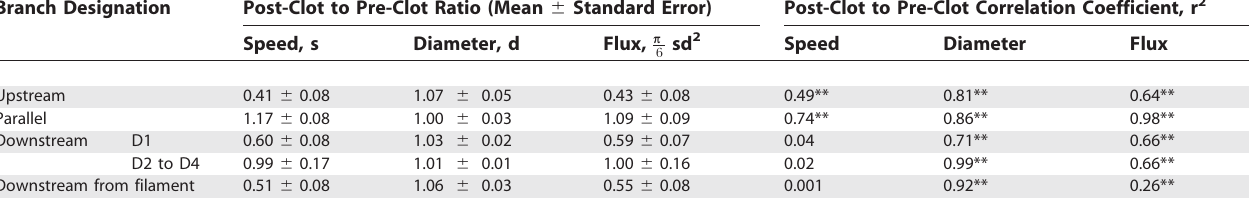
Table 1. Summary Statistics for Changes in Vascular Parameters